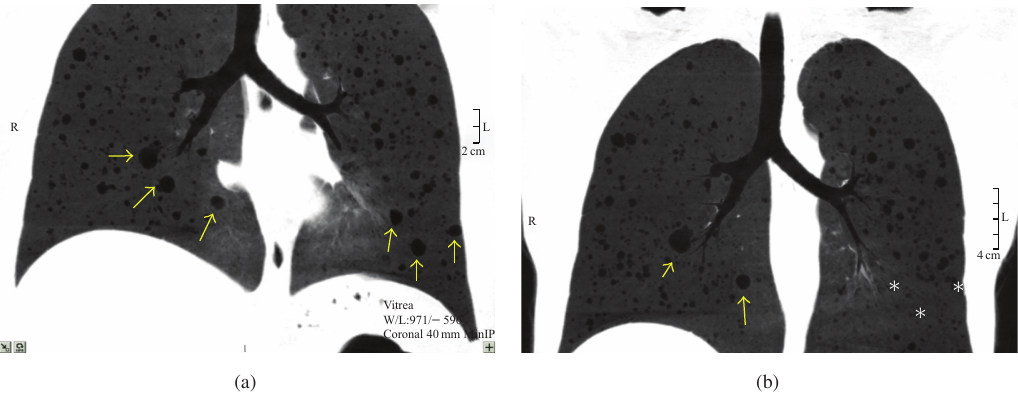
FIGURE 2: (a) Coronal CT revealing pulmonary lymphangioleiomyomatosis with a moderate degree of pulmonary cystic affectation. Three lesions in each lung are identified by arrows. (b) Coronal CT revealing a marked resolution of pulmonary cysts after a 6-month treatment with low-dose rapamycin. One lesion in the right lung and three in the left had become imperceptible (arrows and